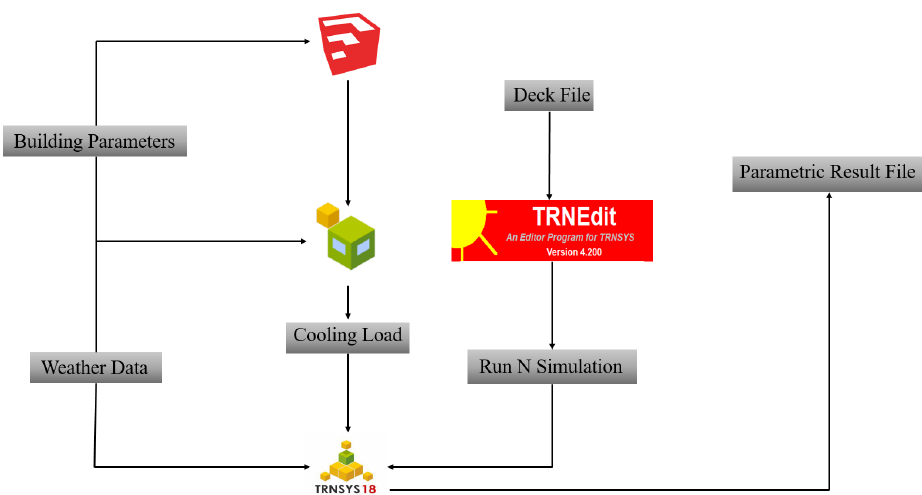
Figure 3. A schematic diagram of the flow chart for the modelling process via the TRNSYS toolbox.